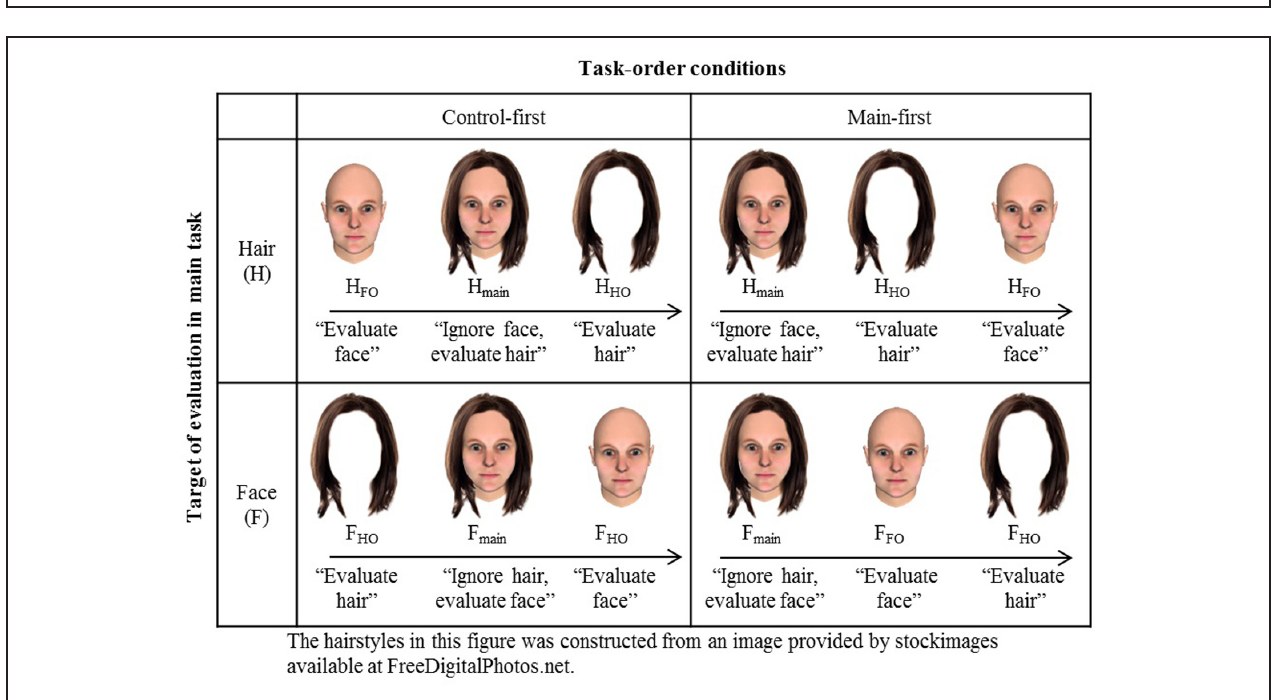
FIGURE 7 | List of conditions in Experiment 2. The abbreviations “H” or “F” were assigned to each session depending on the target (hair: H or face: F) to be evaluated in the main task, where task-irrelevant face or hair should be ignored.